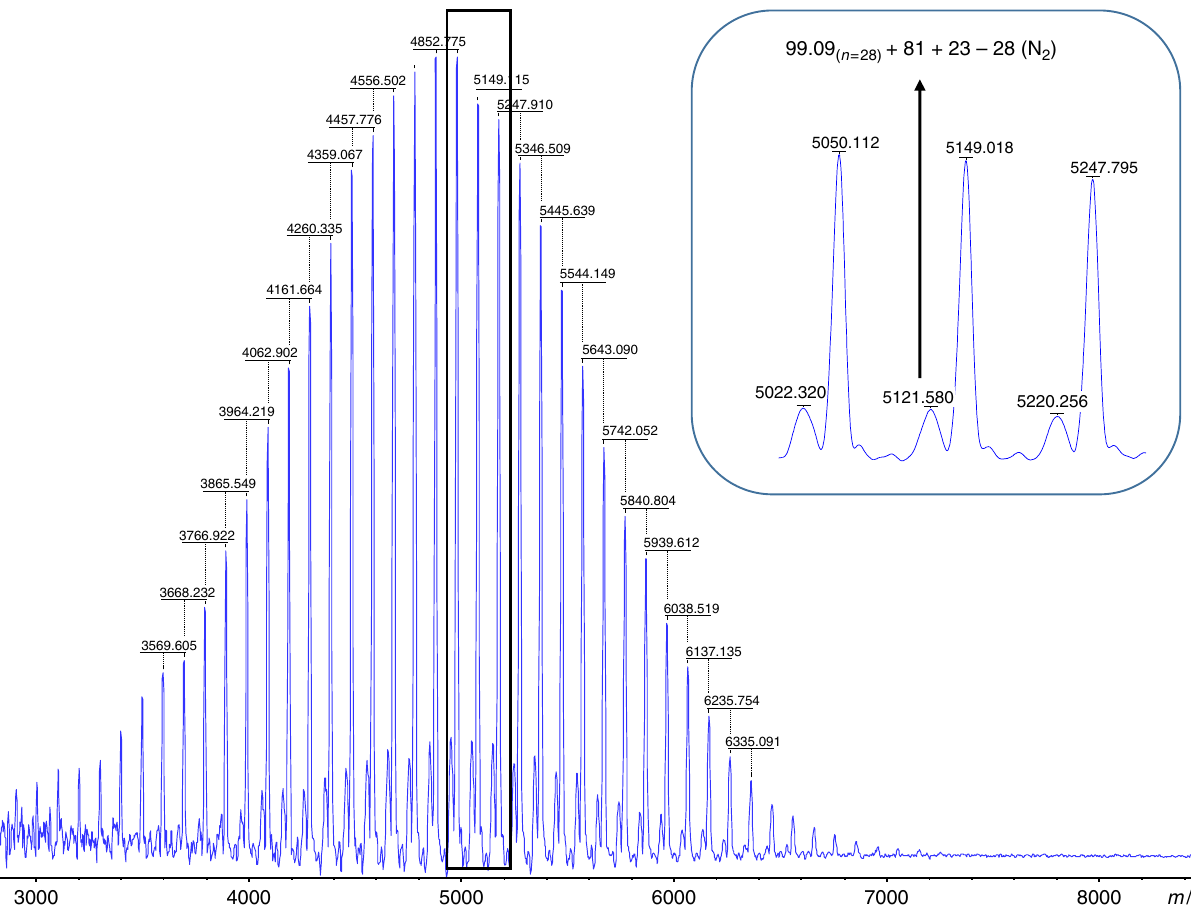
Fig. 5 MALDI-TOF characterization result of the PGA sample corresponding to entry 8, Table 1. The main population corresponds to PGA chains carrying bromo (Br) and hydroxyl (OH) end groups [99.09 n + 81 + 23] with a peak to peak mass difference of 99.09 for one GA unit, and where 81 and 23 are the molar mass of HBr and Na + . One small population showing 28 mass units less than the main population corresponds to the elimination of N 2 during